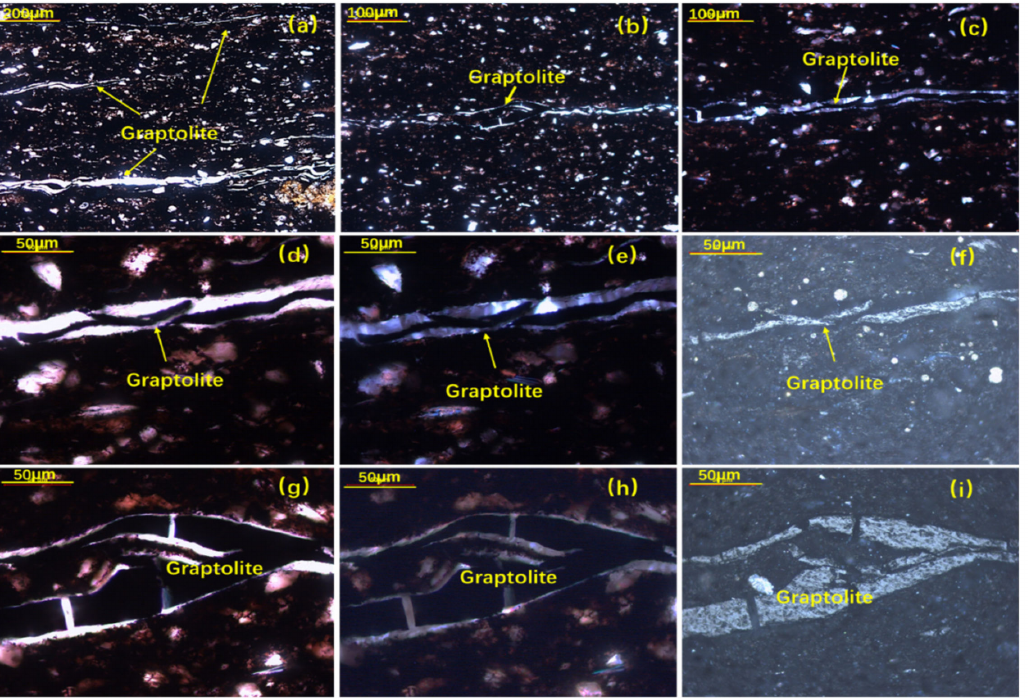
Figure 3. The micro-photos of graptolite. ( a ) Graptolite along the bedding (arrows), transmitted polar- ized light, × 50. ( b , c ) Graptolite along the bedding (arrows), showing the silica content surrounding the graptolite under transmitted polarized light ( b ) and orthogonal light ( c ), × 100. ( d – i ) Grapto- lite showing the silica content surrounding the graptolite under transmitted polarized light ( d , g ), orthogonal light ( e , h ) and reflect light ( f , i ), oil immersion, ×